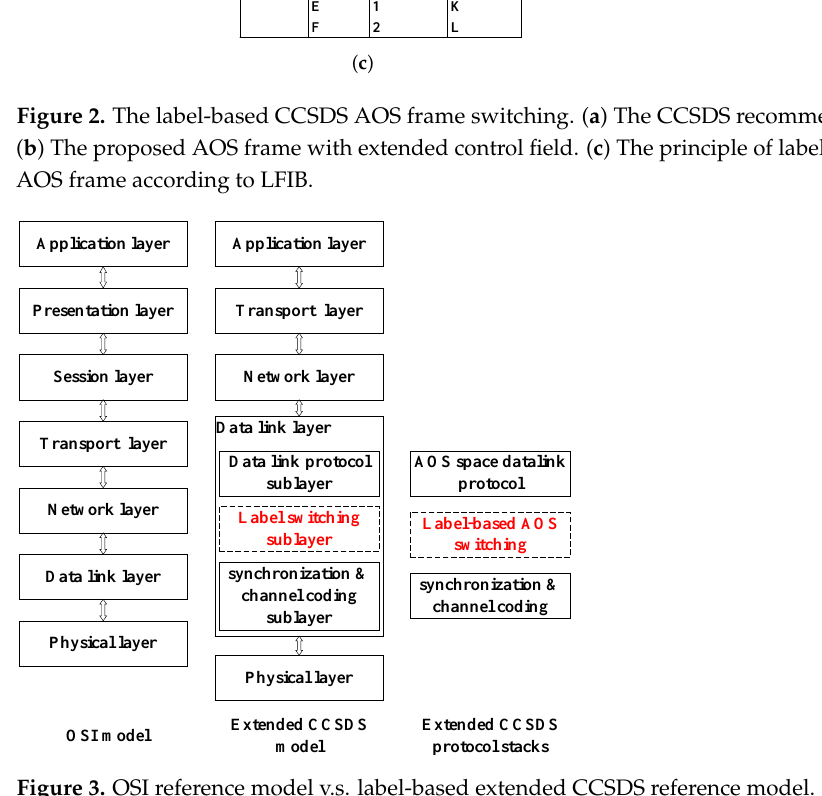
Figure 3. OSI reference model v.s. label-based extended CCSDS reference